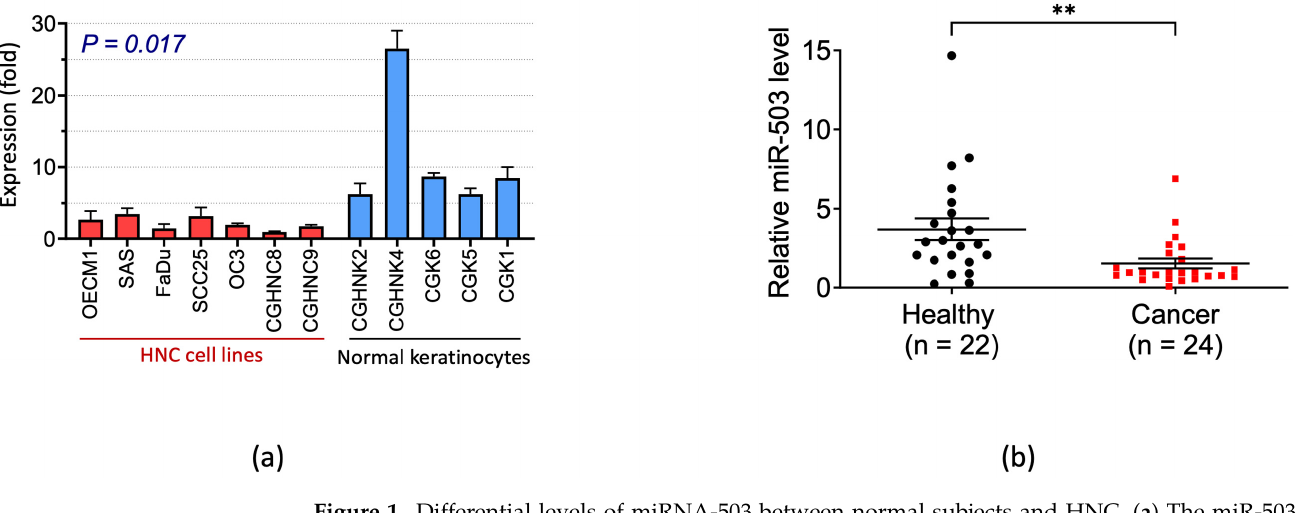
Figure 1. Differential levels of miRNA-503 between normal subjects and HNC. ( a ) The miR-503 expression was significantly decreased in HNC cell lines. HNC cell lines ( n = 7) and normal oral keratinocytes ( n = 5) were used to examine the miR-503 expression levels using RT-qPCR. ( b ) Cancer patients had significantly lower levels of miR-503 in the plasma. The miR-503 levels were determined using plasma samples from HNC patients ( n = 24) and healthy individuals ( n = 22). The statistical significance was calculated with Welch’s t -test (** p = 0.0055).